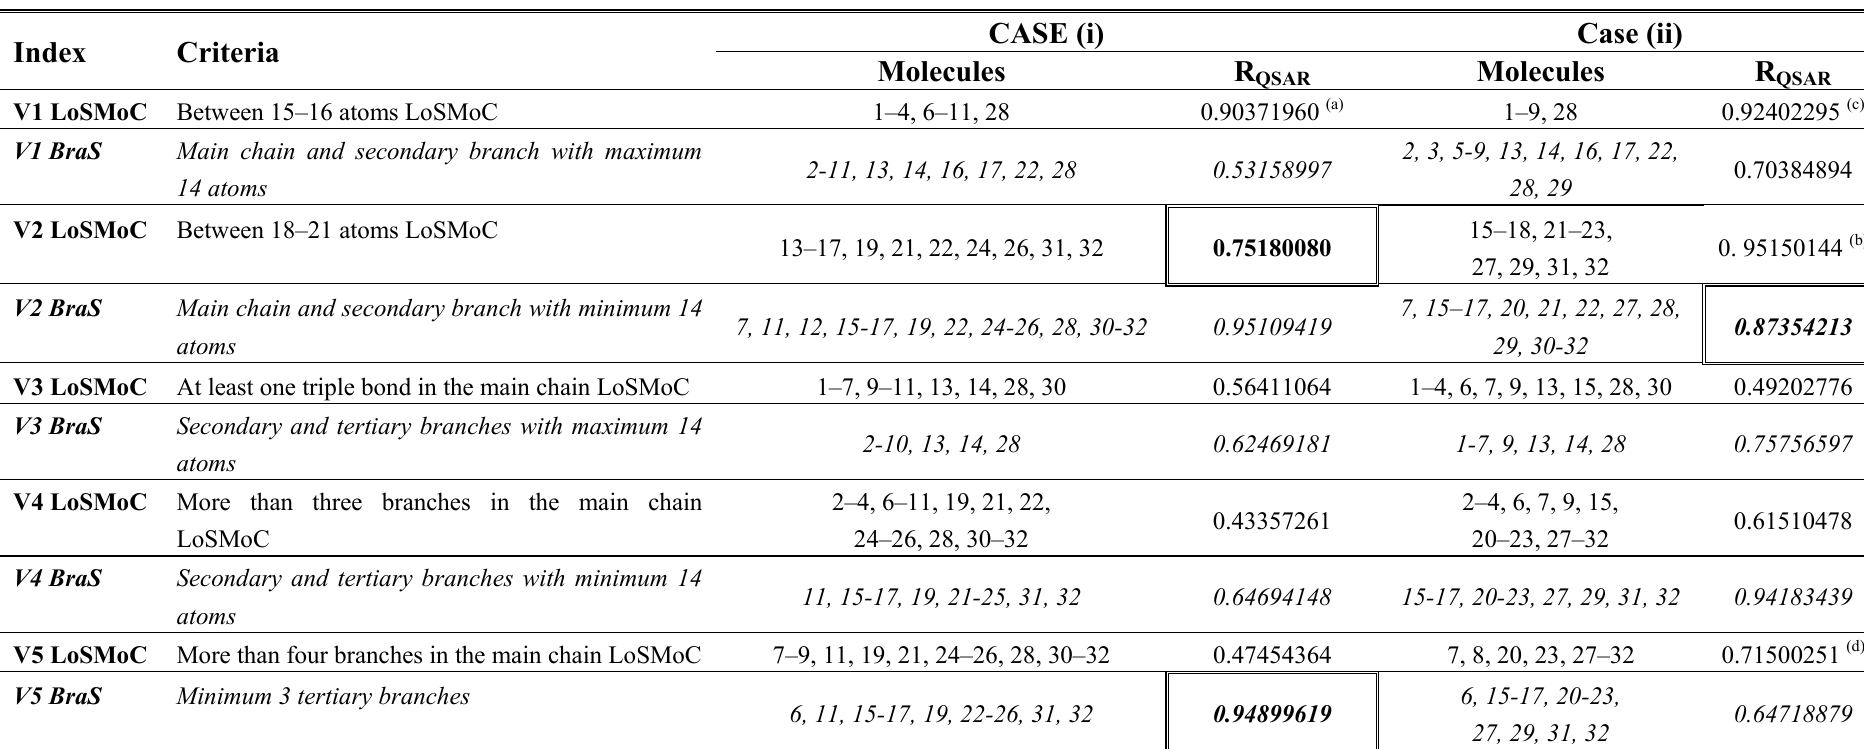
Table 3. Case (i): screening based on SMILES central chain and Case (ii): screening based on SMILES central N-atom neighbors (N3 atom of the pyrimidine) for chain length and atomic neighboring in longest SMILES molecular chain (LoSMoC) in upper entry and the Branching SMILES (BraS) in down entry for various versions (V’s) of SMILES based screening criteria along the molecules of Table 1, respectively. The correlation factors are given for full dependency of parameters of Table 1, i.e. , A = A ( χ , η , π , ω , logP), and for statistical error tolerance of 0.0001, unless otherwise indicated for the best correlation’s combination such that the Topliss-Costello rule [152] for ratio molecule-to- descriptors ≥ 4 to be generally respected (at least for χ & η as the main QSAR descriptors); the marked correlation corresponds with selected criteria and implicitly with the working molecular pool of Table 1 for each SMILES configuration (LoSMoC and BraS) and screening case (i and ii) further considered (see